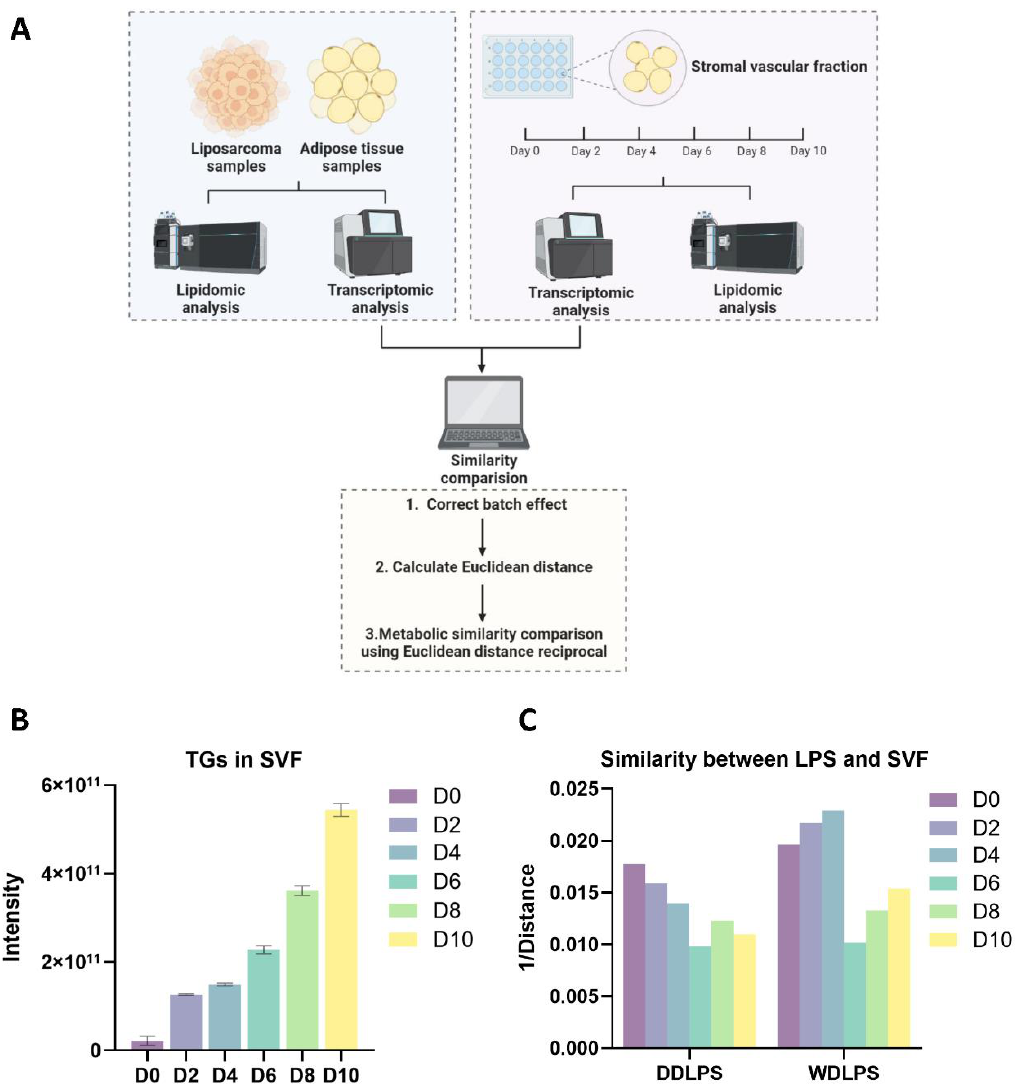
Figure 2. Metabolic similarity comparison between LPS and SVF. ( A ) Overview of the strategy used to compare the transcriptome of LPS tissues and SVF cells. ( B ) The accumulated TGs in SVF cells from day 0 to day 10. ( C ) The bar plot showing the similarity between LPS tumors and SVF cells on day 0, day 2, day 4, day 6, day 8 and day 10. (The figure A was created with BioRender.com, accessed on 10 October